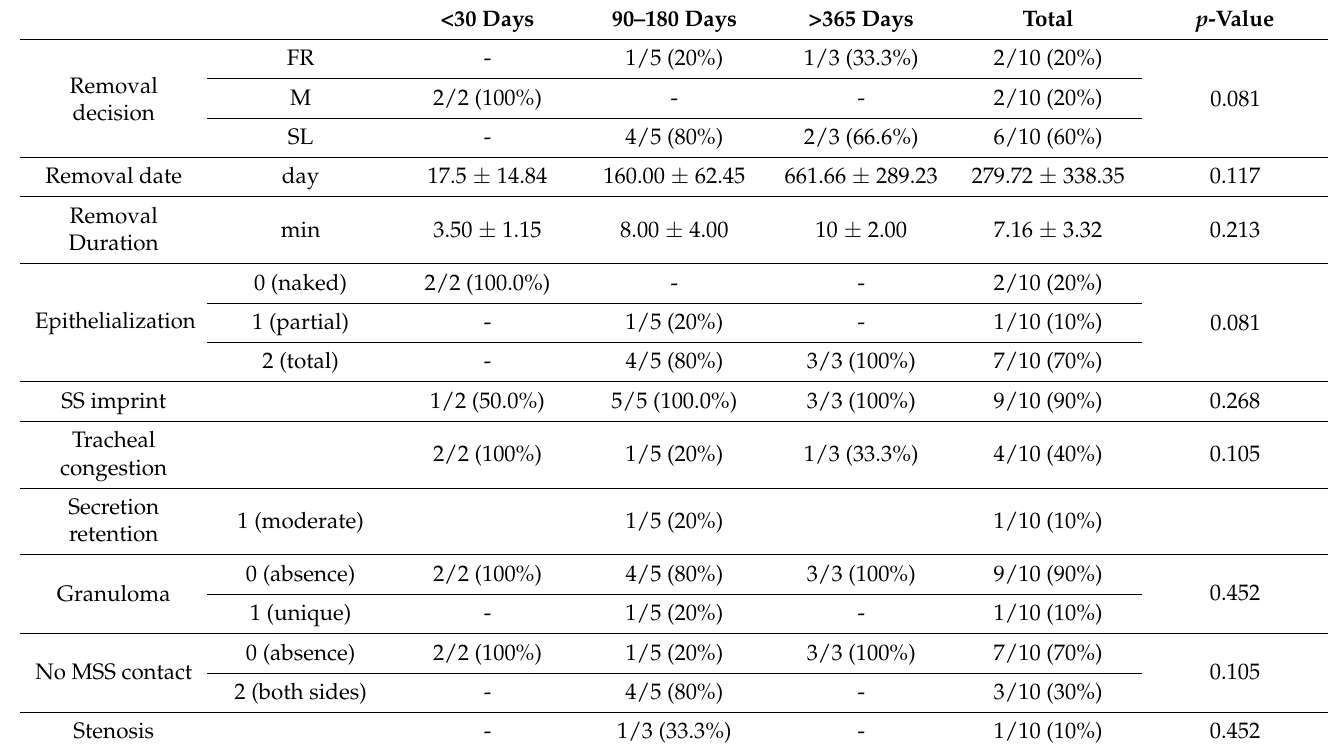
Table 2. Mean results of endoscopic removal and its characteristics. Data are presented as the mean and standard deviation (SD) for normally distributed variables. Data are presented as the median and range for non-normally distributed variables. <30 Days 90–180 Days >365 Days Total p